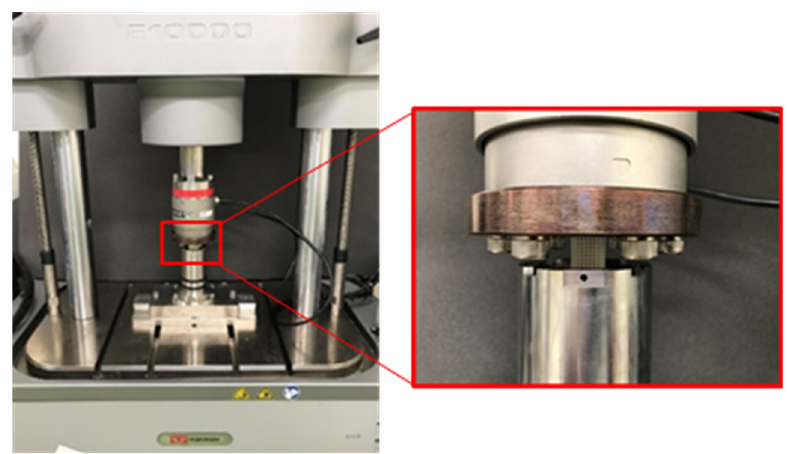
Figure 8. The Zwick Roell 1474 uniaxial compression test equipment.